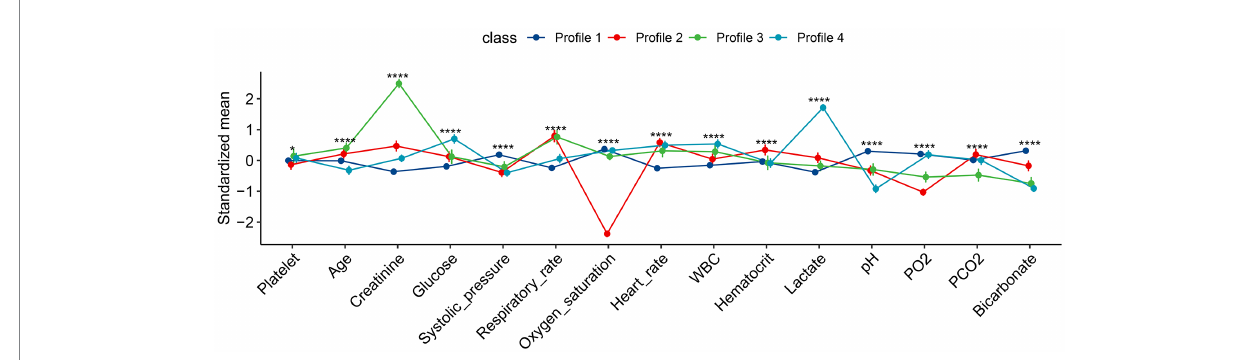
FIGURE 3 Characteristics of the four subphenotypes identified by latent profile analysis. All numeric values were scaled for better visualization on the vertical axis. Profile 1 is the largest class over all study days with all variables in average value (the baseline class). Profile 2 is characterized by low oxygen saturation and partial pressure of oxygen, the highest partial pressure of carbon dioxide (the respiratory failure class). Profile 3 is characterized by the highest serum creatinine and low bicarbonate levels (renal dysfunction class). Profile 4 is characterized by the highest lactate level, and low systolic pressure and bicarbonate level (the shock class). FMM, finite mixture modeling; WBC, white blood cell; PO 2 , partial pressure of oxygen; PCO 2 , partial pressure of carbon dioxide. * p < 0.05, **** p < 0.001.